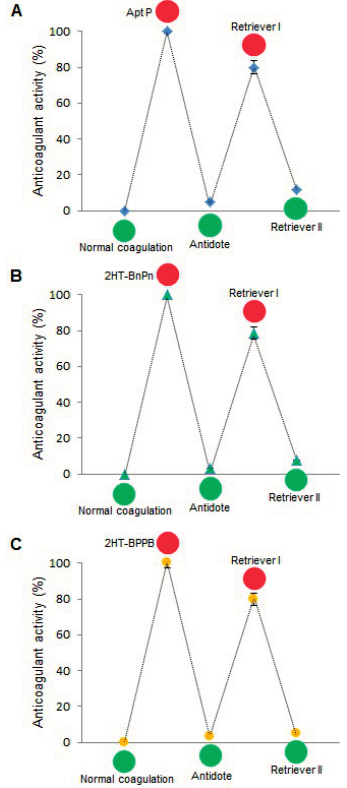
Figure 7. Cycles of antidote/retriever regulation in aPTT assays using ( A ) Apt P; ( B ) 2HT-BnPn and ( C ) 2HT-BPPB. Addition of antidote reverses anticoagulation to less than 10%, whereas addition of retriever I restores it to almost 80%. Retriever II reverses anticoagulation back to less than 10%. The % anticoagulant activity is calculated as described in Materials and Methods. Error bars represent SEM. Raw clotting times are provided in the Supplementary Materials (Table